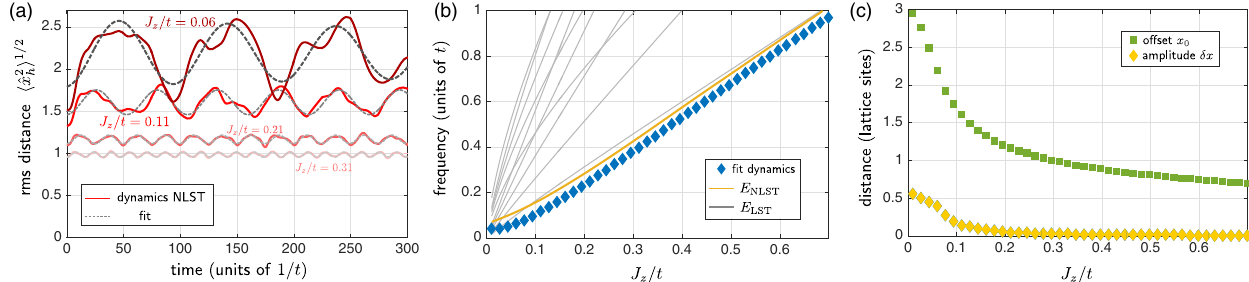
FIG. 19. Bloch oscillation spectroscopy of magnetic polarons, at S ¼ 1 /2. We start from a magnetic polaron in its rovibrational ground state and assume that the spinon is localized in the center of the lattice. Then a weak force F ¼ 0 . 05 t / a is applied along the x direction at time t 0 ¼ 0 . (a) Subsequently, the rms radius of the hole distribution along the force, h ˆ x 2 / t . It was calculated in the spinon frame. The strongest oscillations come from rotational excitations at the depending on the ratio J z frequency ω , but admixtures from vibrational states are also visible. (b) We extract the frequency ω from fits to data like shown in (a) and plot it as a function of J / t . It is approximately equal to the excitation energy Δ E of the first rotational eigenstate of the holon on the z Bethe lattice. (c) The offset x 0 and the amplitude δ x of the oscillations observed in (a) are plotted as a function of J calculations we used NLST in the spinon frame, assuming a maximum string length l